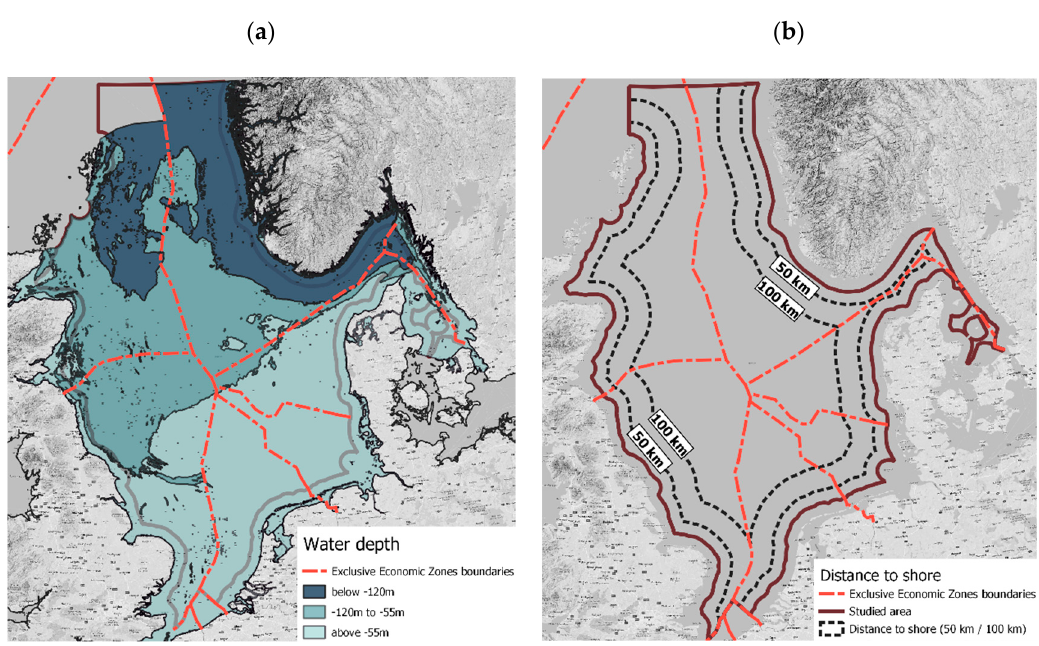
Figure 2. ( a ) Water depth and ( b ) distance to shore.